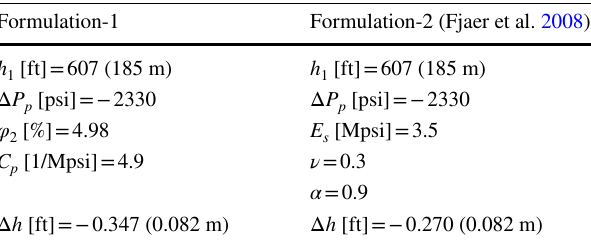
Table 5 Parameters for estimation of the subsidence (change of res- ervoir thickness or ground level) for Asmari carbonate reservoir, refer Eq. 22 (Formulation-1) and Eq. 23 (Formulation-2)